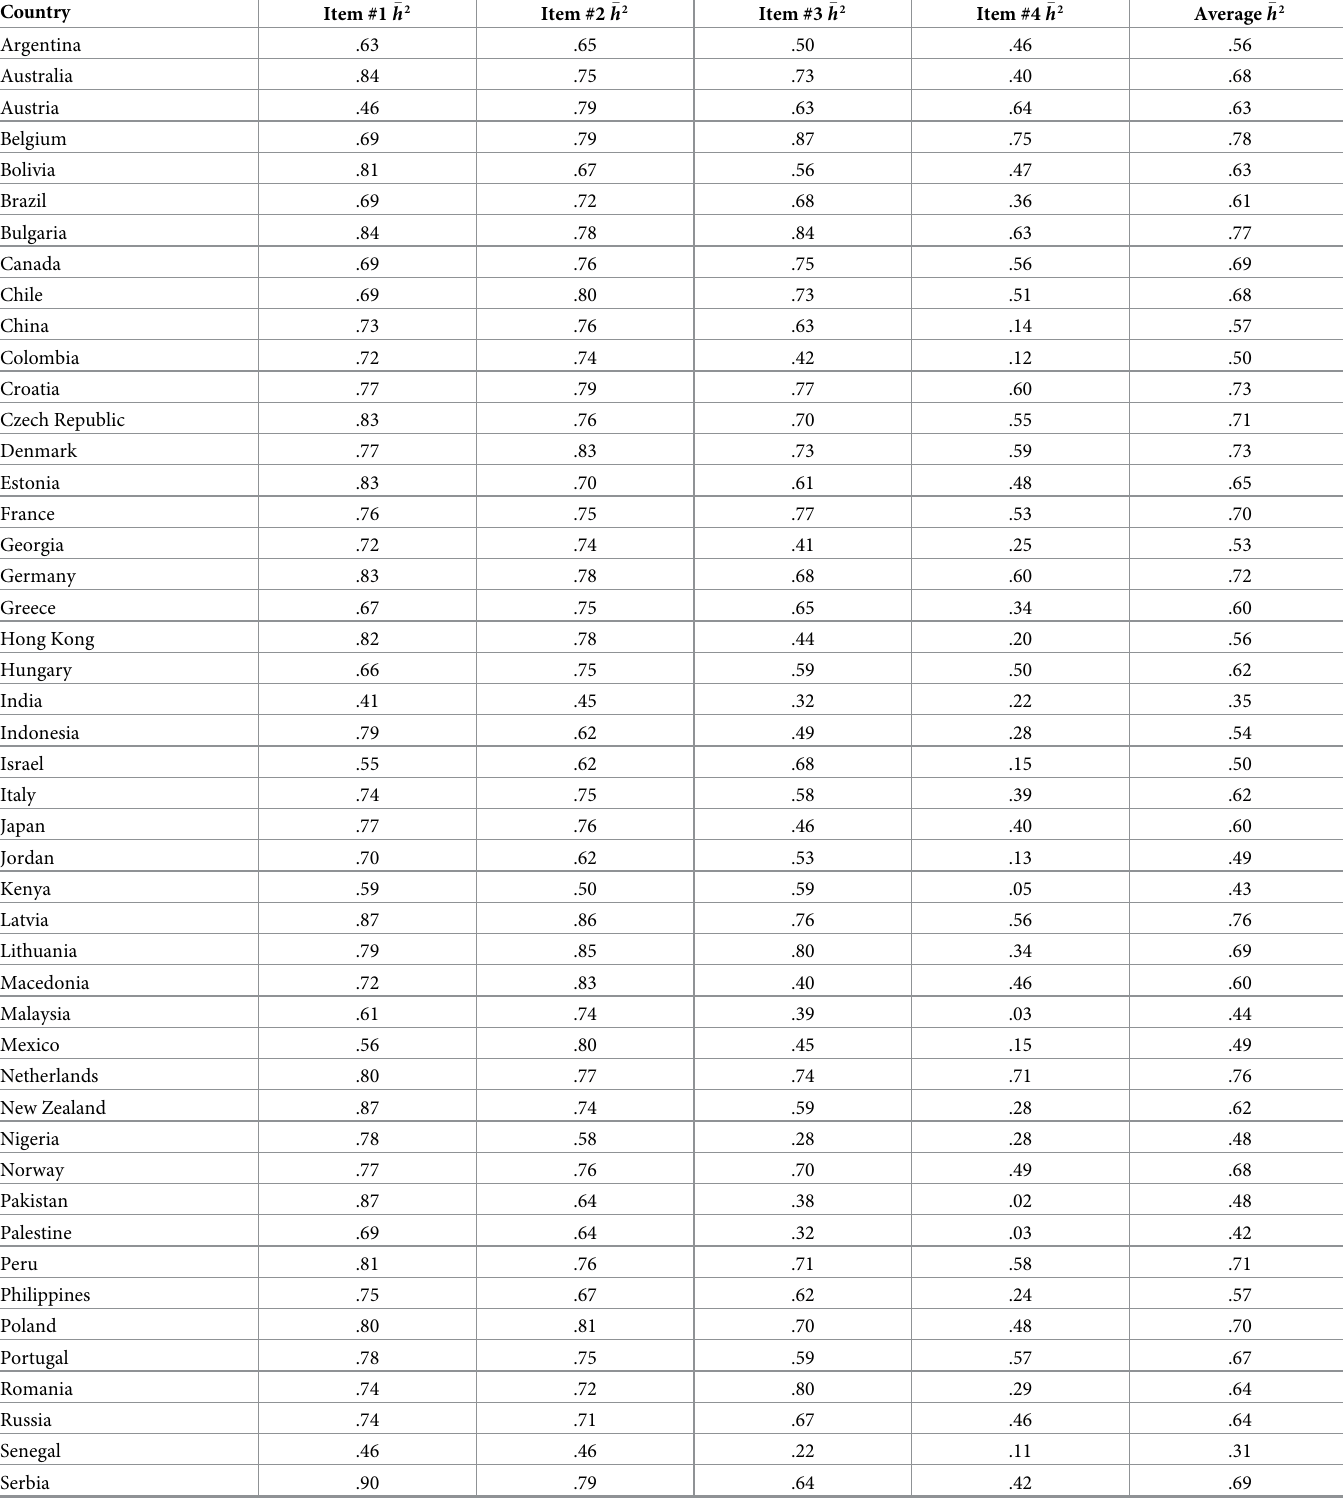
Table 5. Communality scores ( � h 2 ) for the Subjective Happiness Scale (SHS).